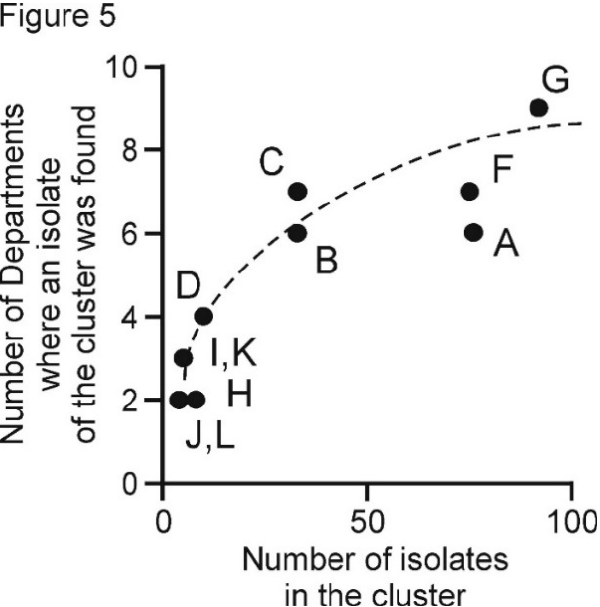
Figure 5. Graph of the number of Peruvian Departments in which an isolate of each potato virus X cluster was found, plotted against the number of isolates in each cluster. Letters A–L stand for the clusters A–L in Table 2 and Figure 2. As there were no Peruvian isolates within cluster E, it is not included in this Table 4. Genetic links (gene flow) between the potato virus X concat populations of eight different Peruvian Departments.